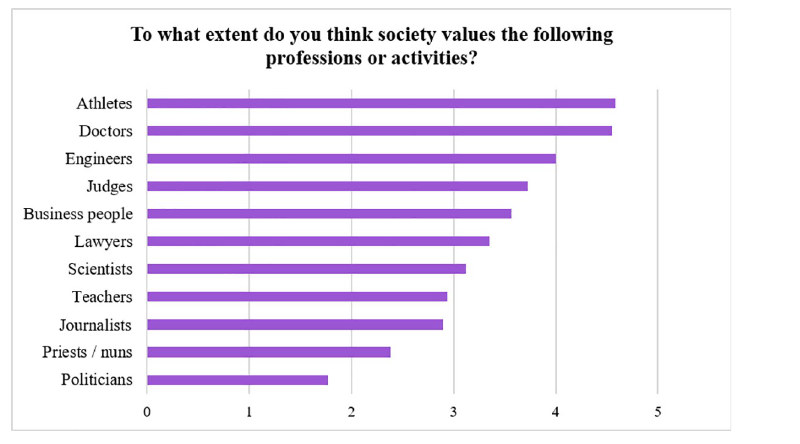
Fig 1. Scientists’ views of public valuing of professions.